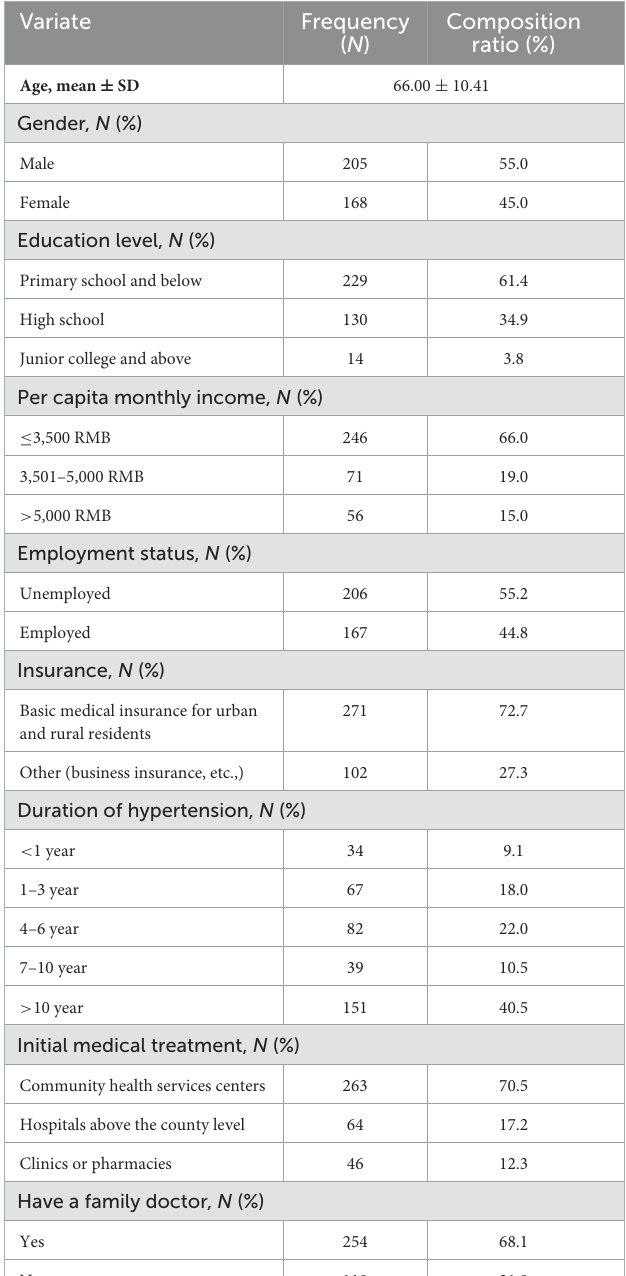
TABLE 1 Sample demographics ( N =